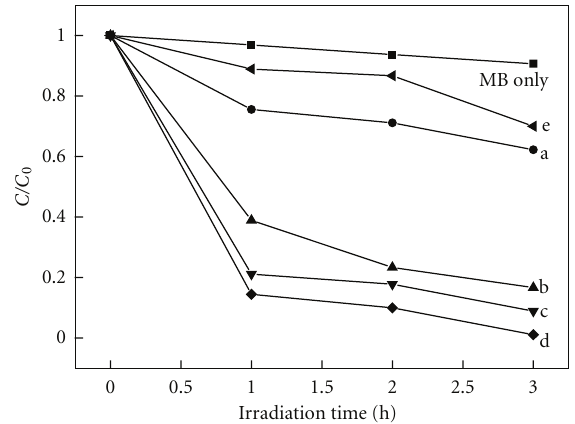
Figure 5: Photocatalytic activities of samples under di ff erent pH at 110 ◦ C. (a) pH = 1.0, (b) pH = 3.0, (c) pH = 5.0, (d) pH = 7.0, (e) pH =